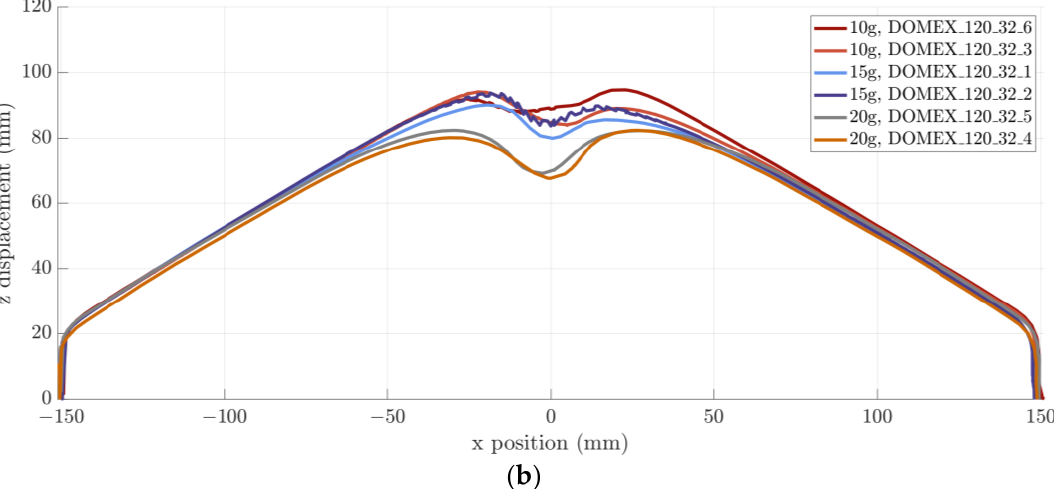
Figure 10. Permanently deformed profiles of blast tested V-structures (120° internal angle, 32 mm tip radius) of the ( a ) ridge plane, ( b ) cross-cut plane.